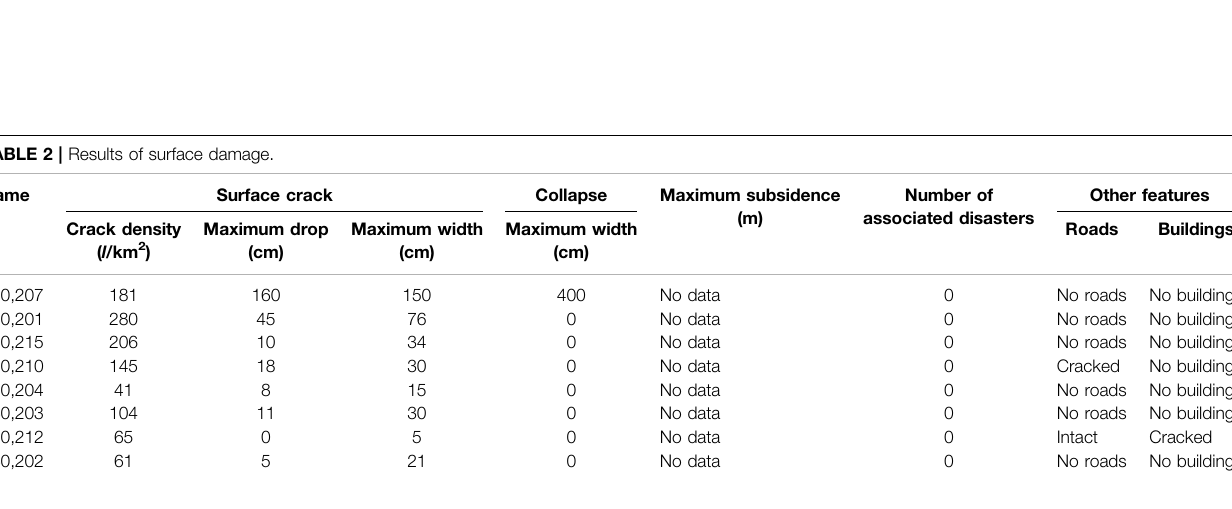
TABLE 2 | Results of surface